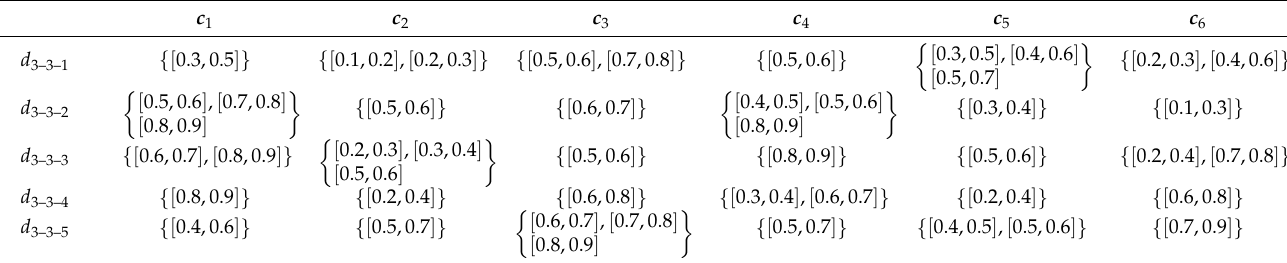
Table A16. Scoring matrix of natural environment d 3–3 .